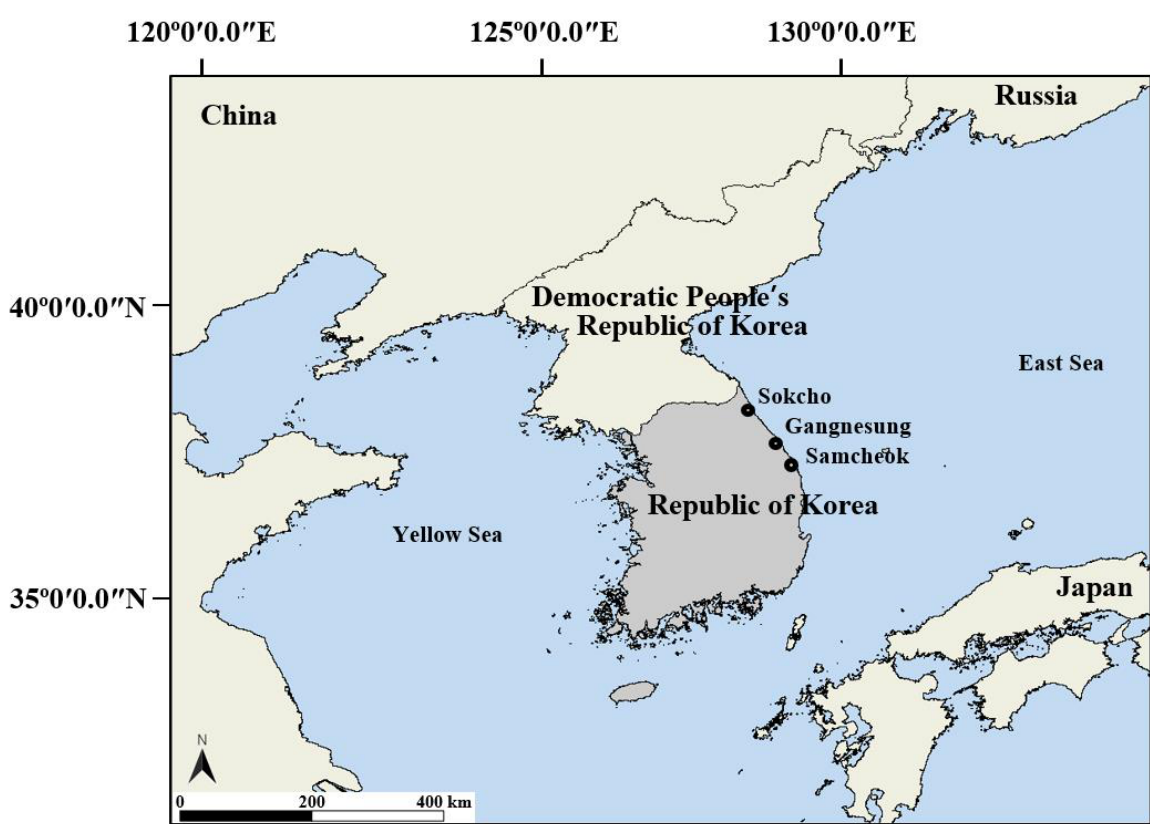
Figure 1. Study regions in the Republic of Korea. These regions, belonging to Gangwon-do Province, are located along the east coast where large-scale forest fires are a frequent occurrence.